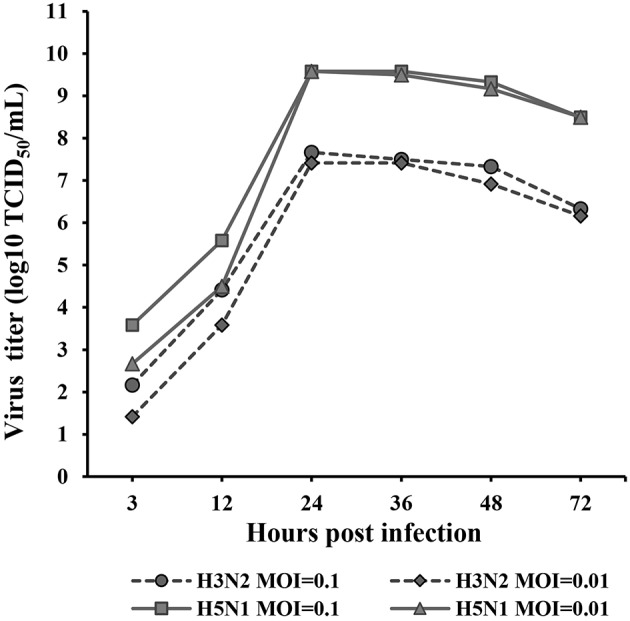
Replication kinetics of H3N2 and H5N1 in MDCK cells. Monolayers of MDCK cells were infected with each virus at MOIs of 0.1 and 0.01. Virus titers were determined using the TCID50 assay at 3, 12, 24, 36, 48, and 72 hpi. TPCK-trypsin (0.25 mg/mL) was added to the medium to promote the propagation of the H3N2 influenza A virus. The data were analyzed using one-way ANOVA (p < 0.05). Data are presented as the means ± SD of independent triplicate experiments.